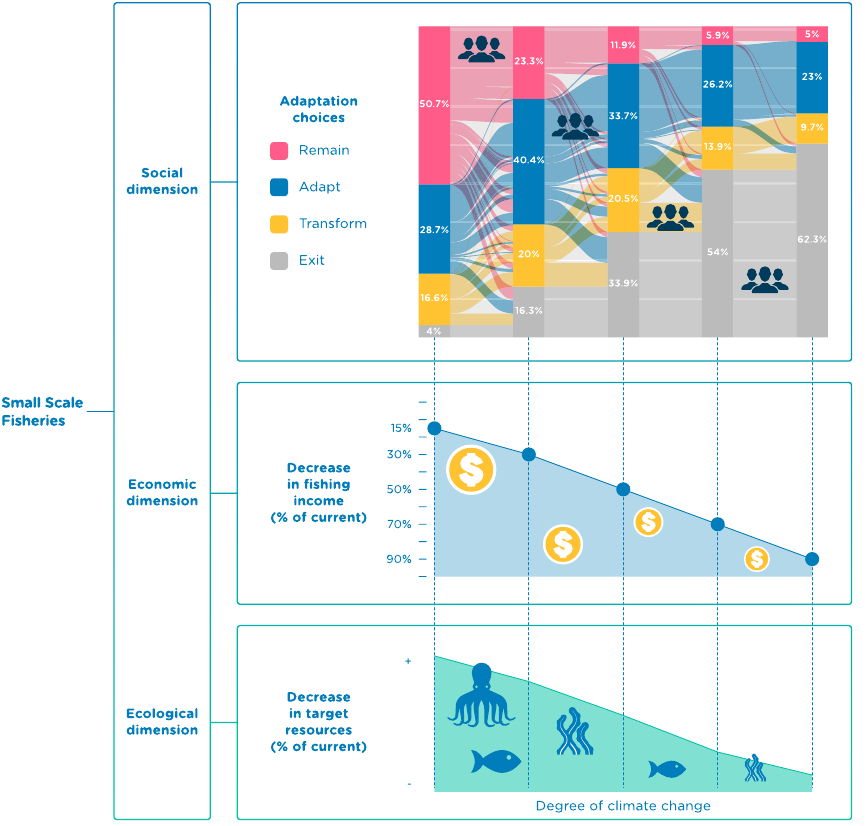
Figure 3. Small-scale fishers’ individual responses to incremental climate change impacts on marine resources (n = 404). Ecological, economic, and social dimensions of the SSF interlinked. The ecological dimension reflects the decrease of target resources. The economic dimension represents a decrease in fishing catches and therefore income, according to climate change impact scenarios presented to respondents. The social dimension above shows our results in terms of the number of respondents who chose each type of response, reflecting the main stated adaptation pathways fisher’s follow when presented with increasing climate impact